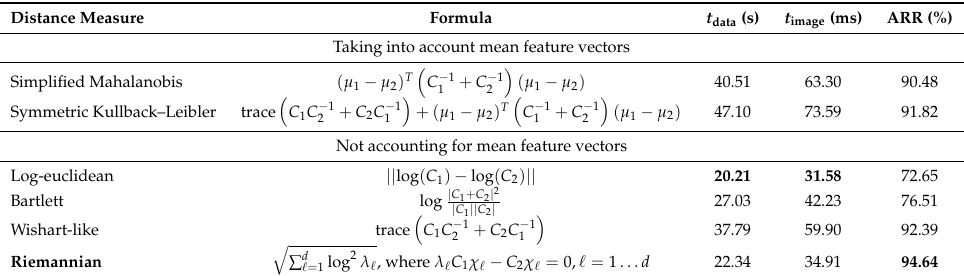
Table 10. Sensitivity to distance measures in terms of dissimilarity measurement time and average retrieval rate (ARR). Experiments were conducted on the Vistex-640 database using the 27D LED